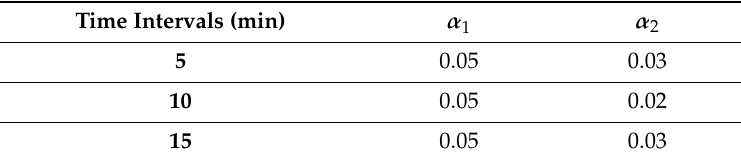
Table 2. CN2 rule setting parameter values.